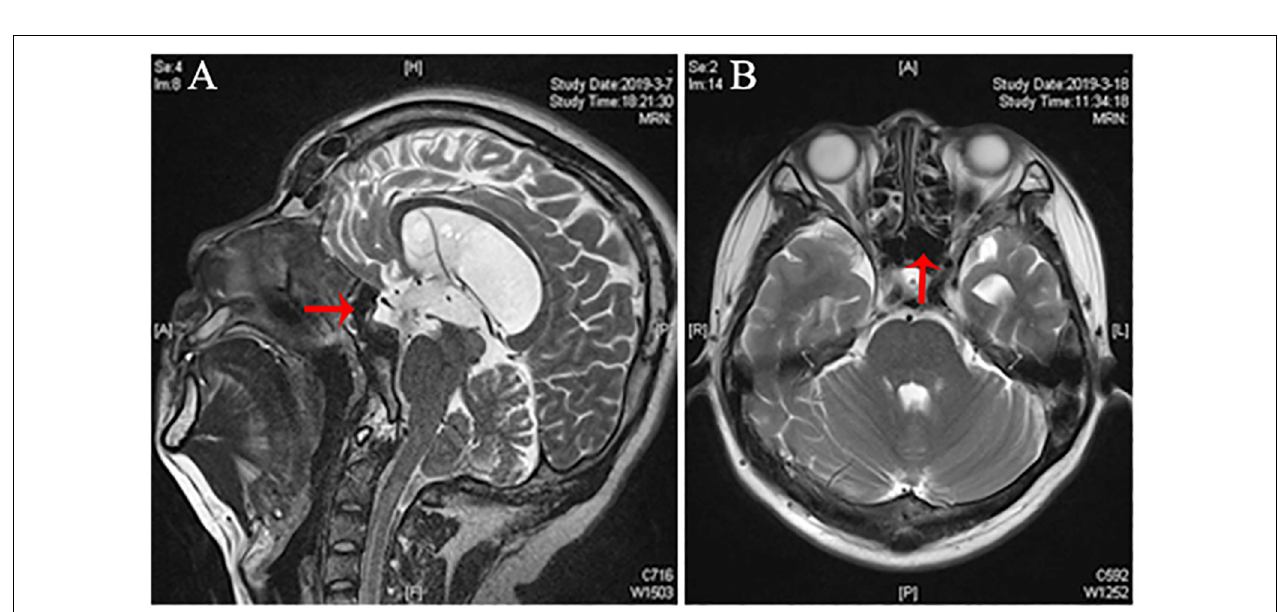
FIGURE 3 | Post-ETV MRI of the patient with CSF rhinorrhea. (A,B) Post-ETV sagittal and axial T2-weighted MRI demonstrating CSF flow signal disappeared significantly compared to the preoperative image in the left sphenoidal sinus (arrow).